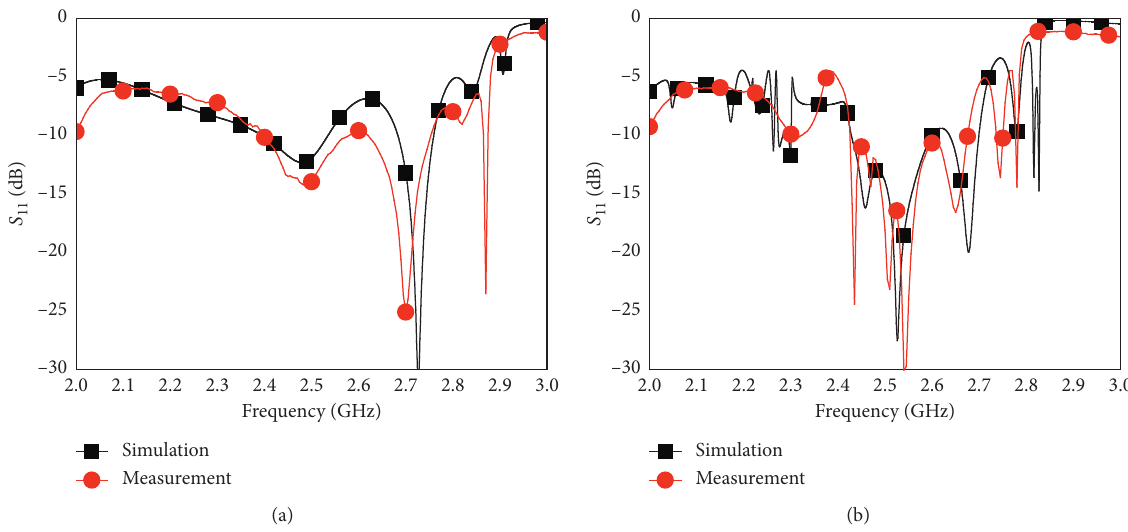
Figure 17: Comparison of the S11 (prototype). (a) Antenna array without SRRs. (b) Antenna array with